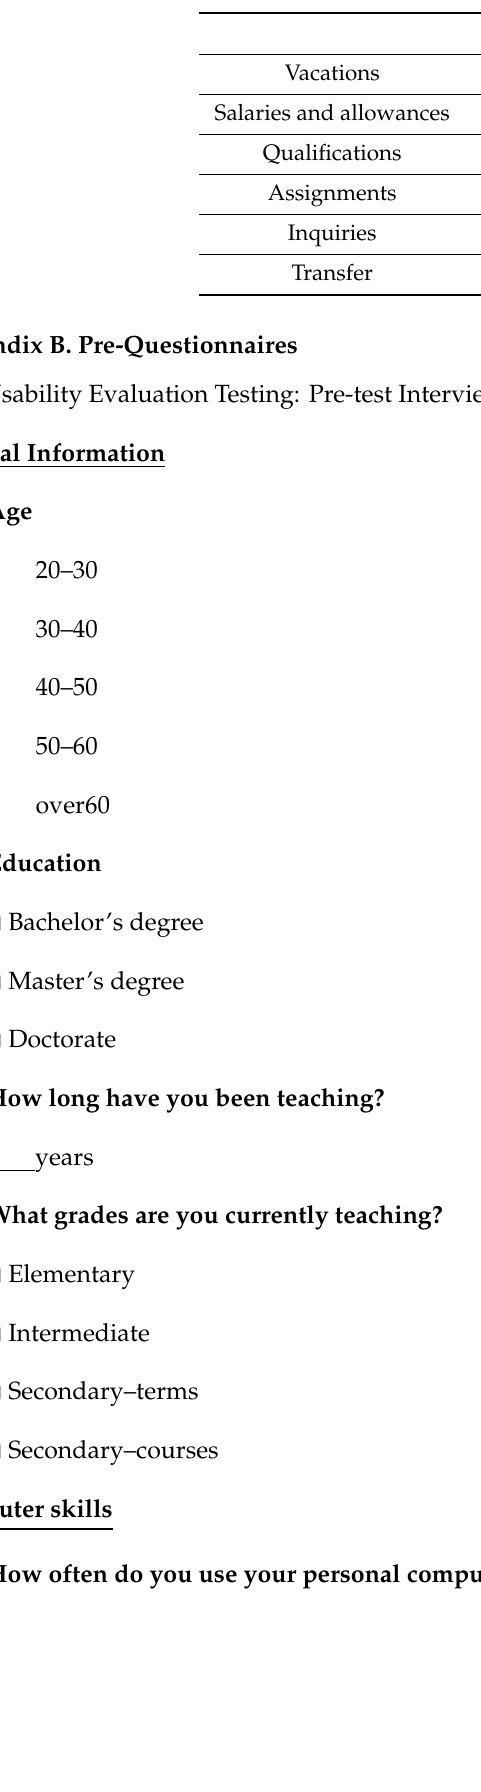
Table A3. Rank the services you use in the iEN